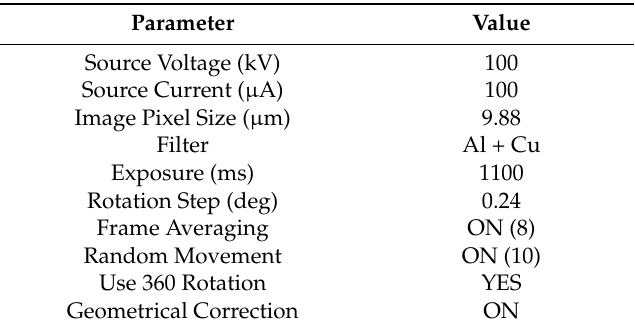
Table 3. Selected major scanning parameters.